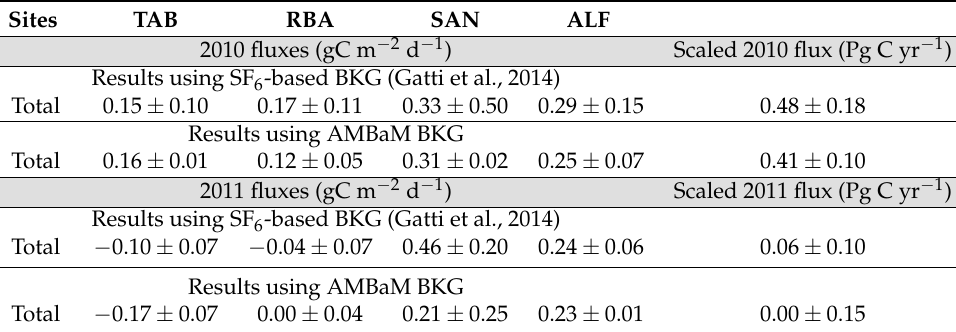
Table 1. Comparison between BKG methodologies on flux